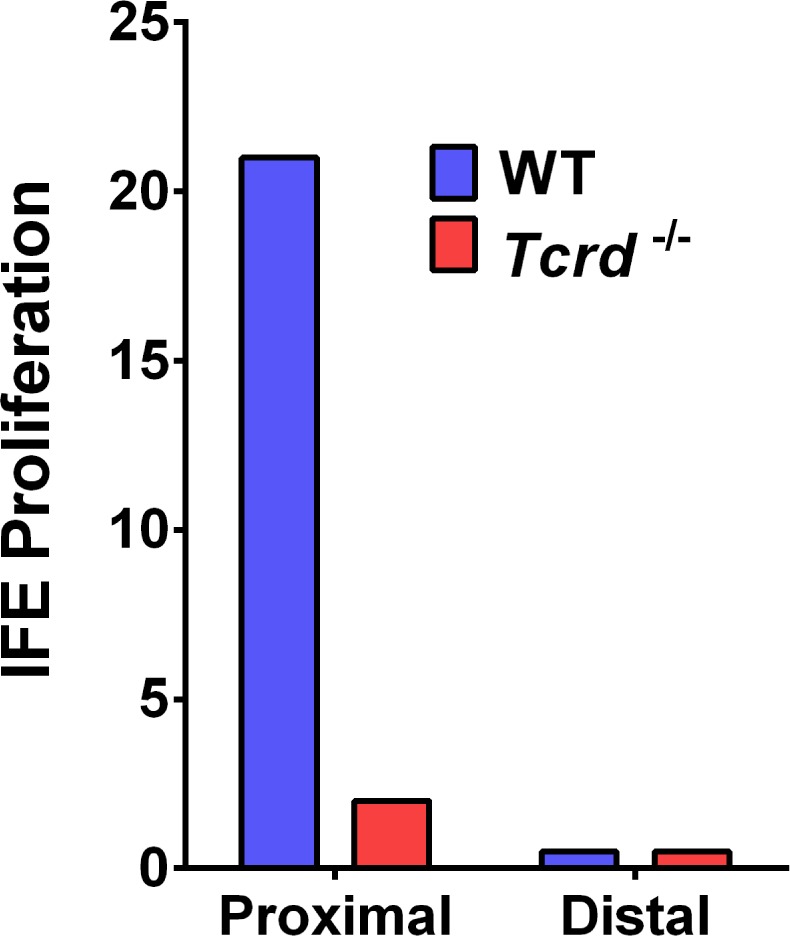
Effect of γδT-cells on IFE proliferation.The cell counts of Edu+ proliferating interfollicular epidermal (IFE) cells in skin wounds of WT and γδT-cell-deficient mice. The proximal area of measurement was restricted to the first three hair follicles adjacent to the wound edge. The cell counts from a region 2 cm away from wound centre was considered to be distal.